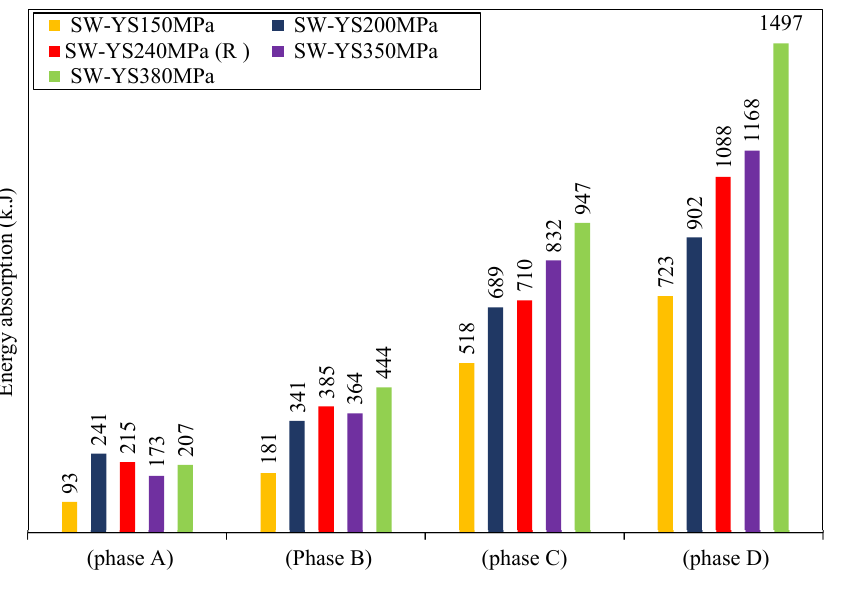
Figure 22. Energy absorption of group 3.